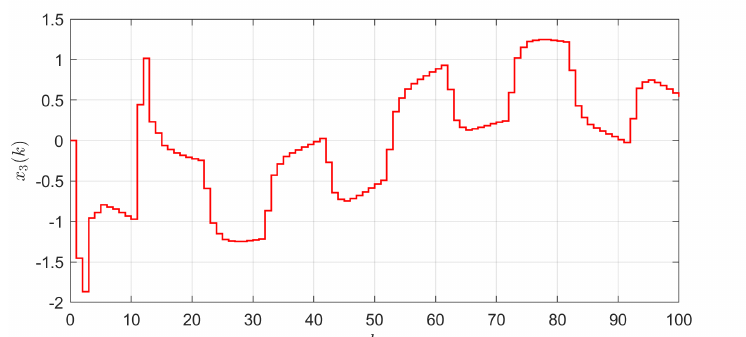
Figure 9. Third state variable.